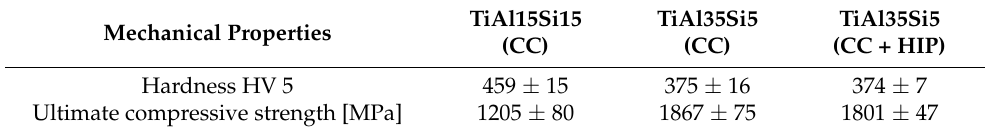
Table 1. Mechanical properties of tested